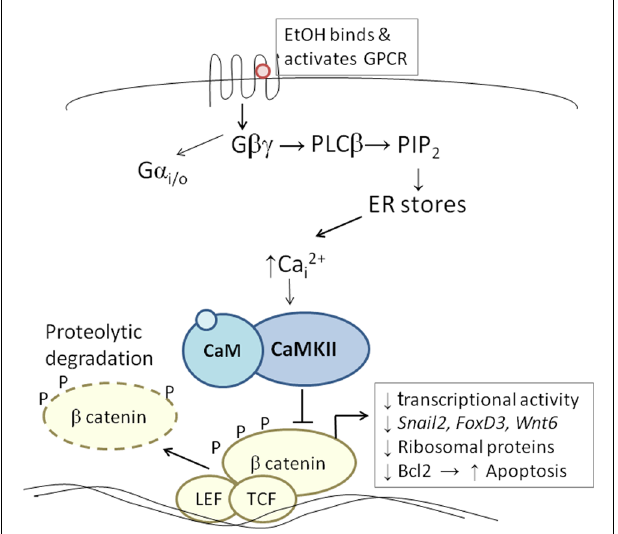
FIGURE 1 | Diagram of the calcium/ β -catenin pathway by which ethanol causes the apoptosis of cranial neural crest populations, as deciphered for chick embryos having 1–10 somites; additional details in text. Ethanol’s interaction with a G-protein-coupled receptor of unknown identity activates a calcium transient that originates from G βγ , PLC β , and phosphoinosityl phosphate release.The calcium transient stimulates calmodulin and CaMKII. CaMKII phosphorylates and thereby destabilizes β -catenin, abrogating the latter’s transcriptional activity.This removes trophic support from neural crest including genes critical for neural crest development ( snai2 , FoxD3 , Wnt6 ). Accompanying reductions in bcl2 and ribosomal proteins may also be